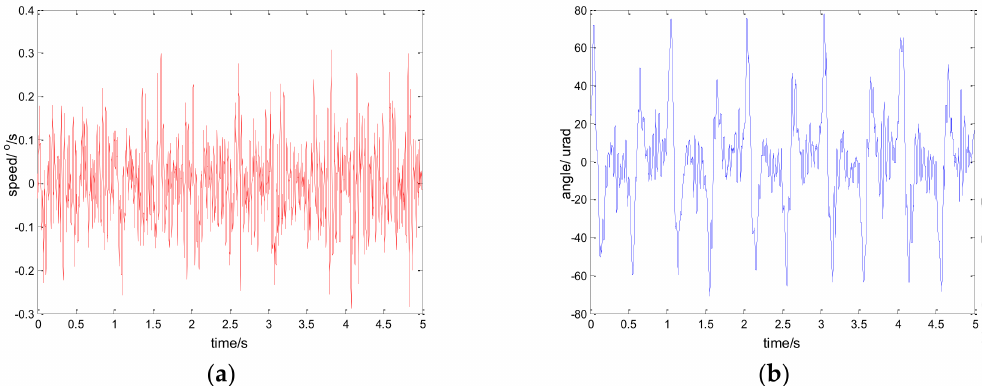
Figure 10. Experiment results of robust SMC with Euler. d = sin ( 2 π t ) : ( a ) speed; and ( b ) tracking error, RMS = 25.7942 urad.